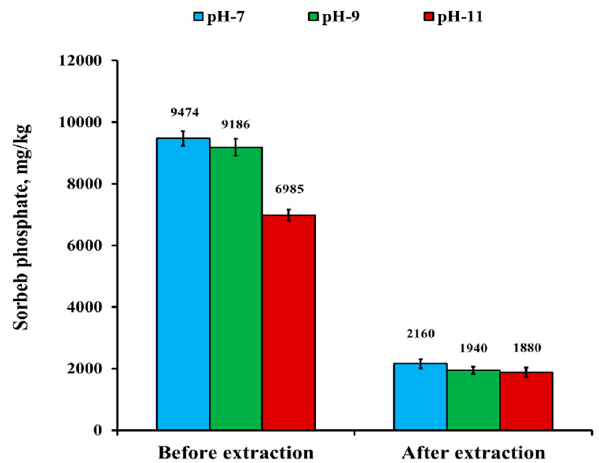
Figure 4. Effect of pH on PO4 − 3 sorption by nSD-KF before and after hot water extraction at the equilibrium time of 2 h and temperature of 298 K.